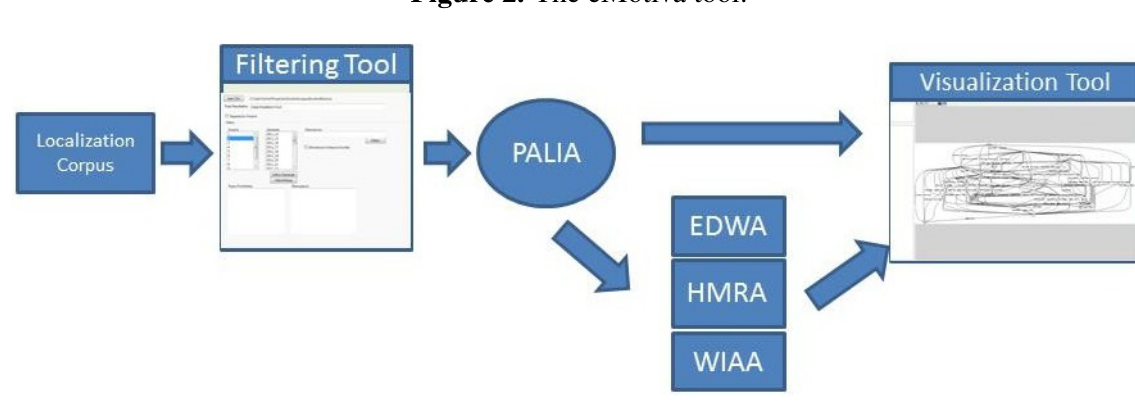
Figure 2. The eMotiva